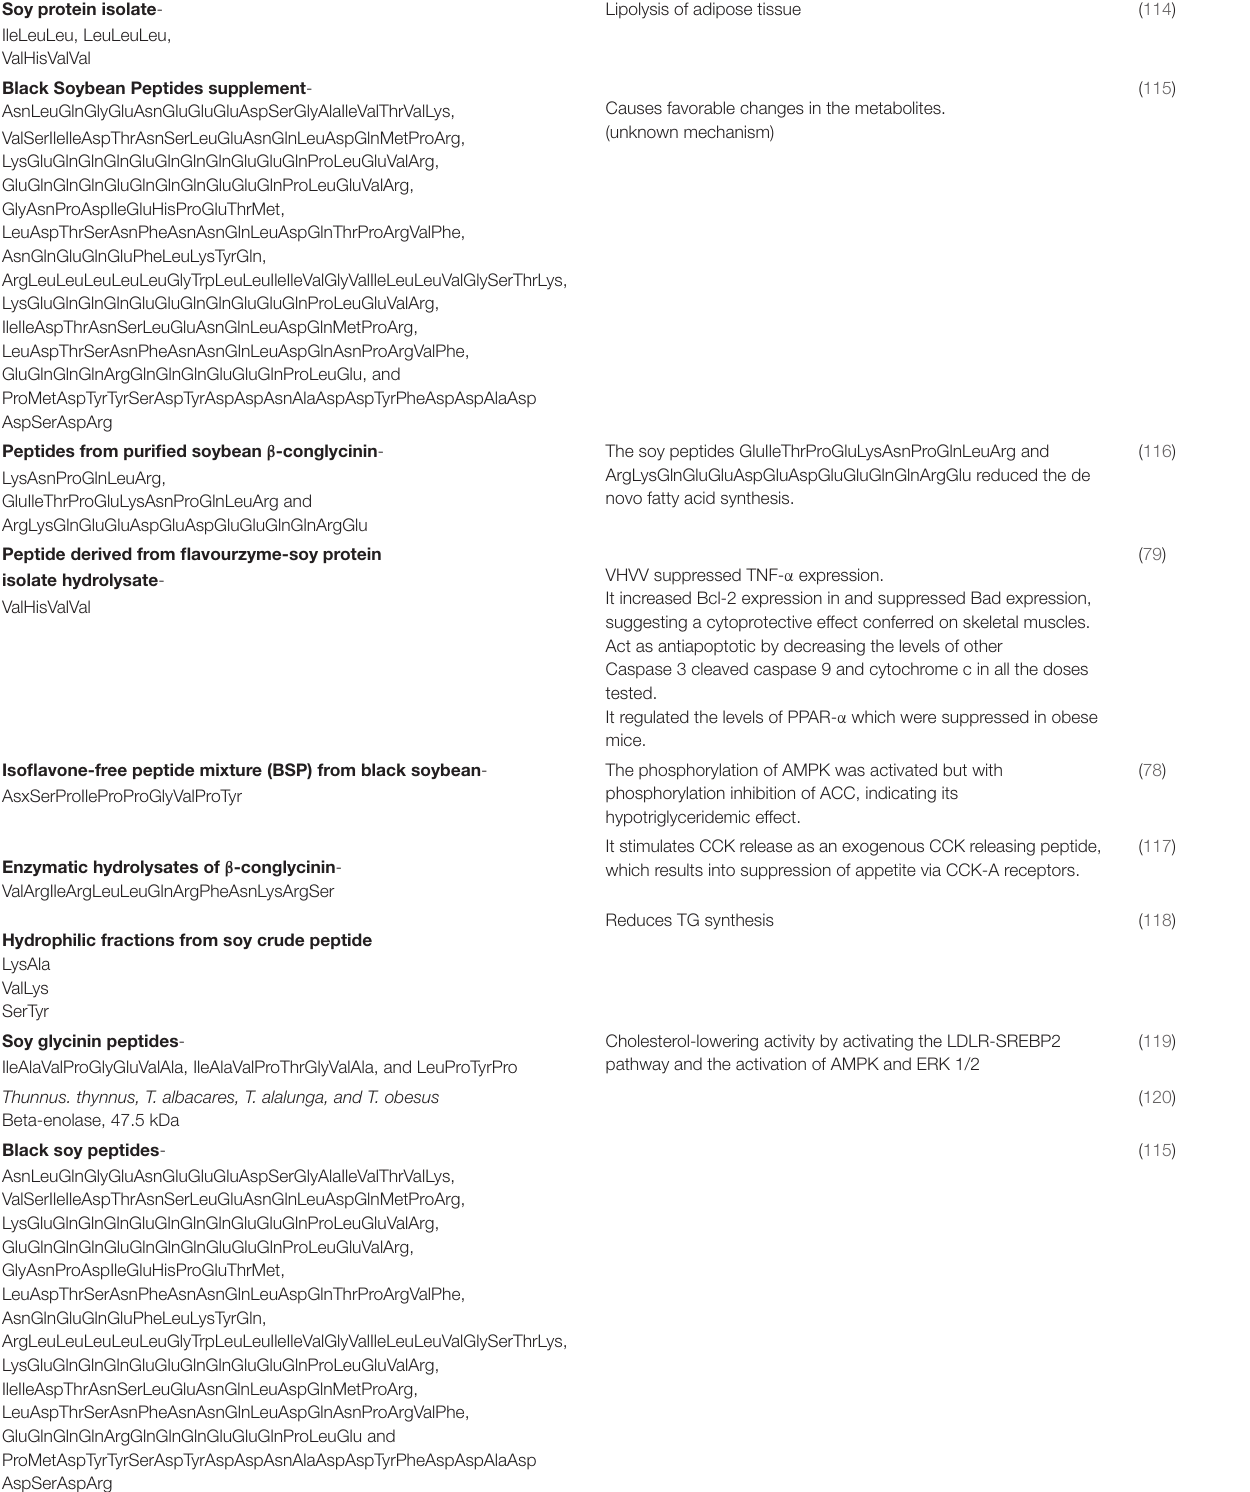
TABLE 3 | Peptidomimetics and peptides from food and marine sources for antiobesity effects. Soy protein isolate